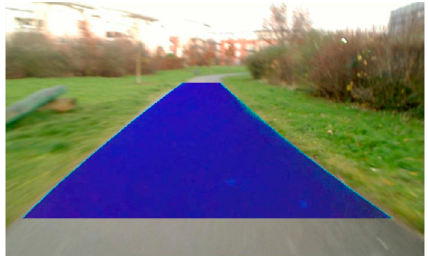
Figure 5. Road detected by the color-based road detector.